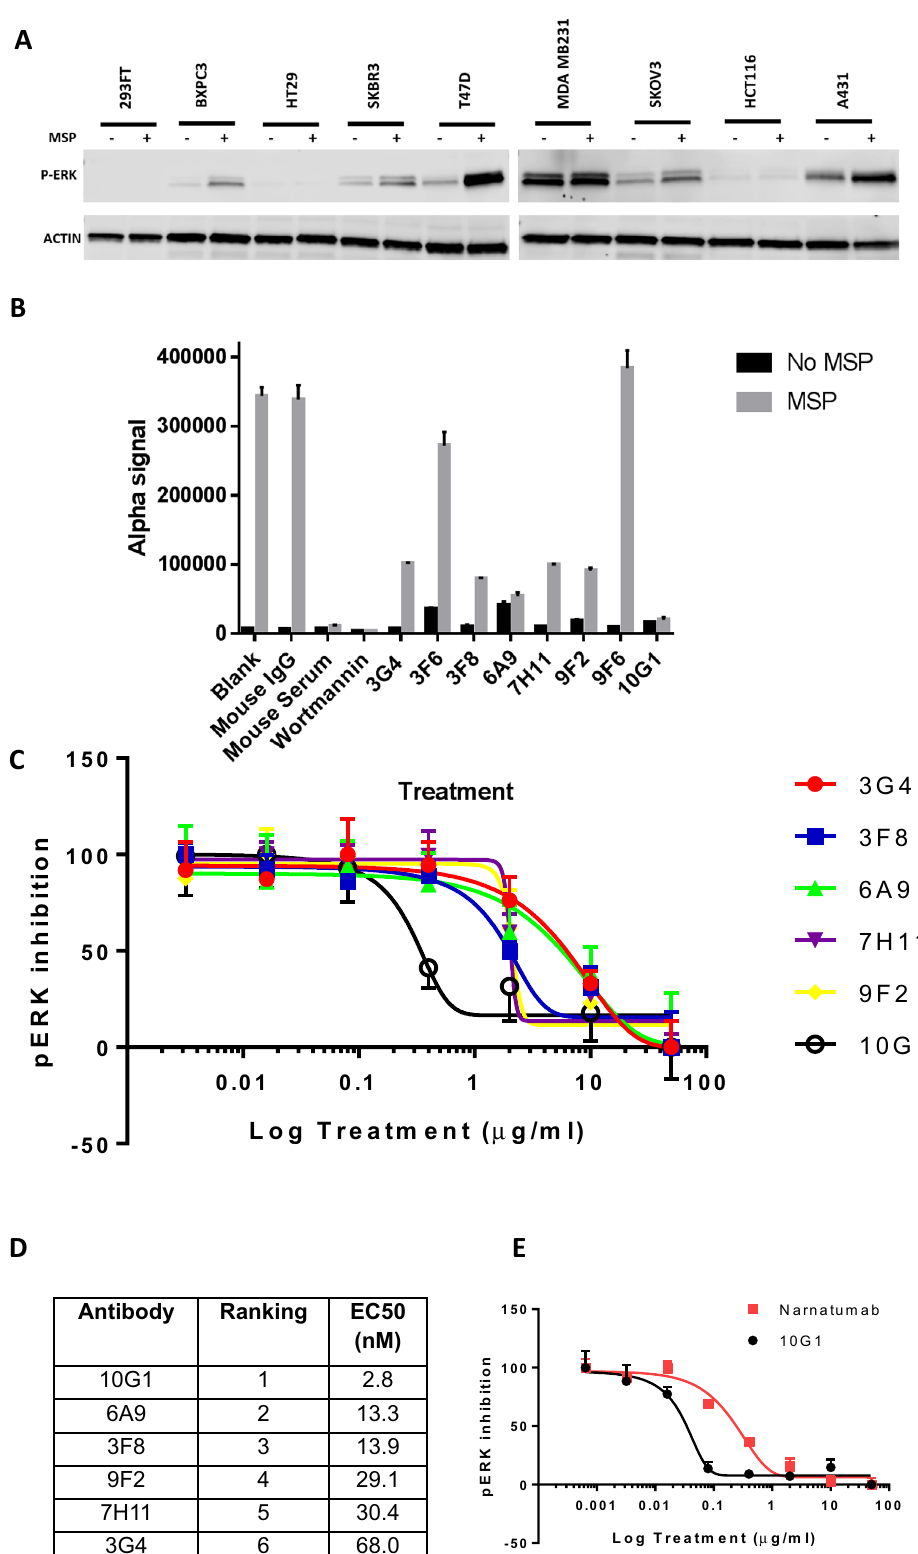
Figure 3. Anti-RON antibodies exert antagonositic effects on MSP induced increase in levels of phosphorylated